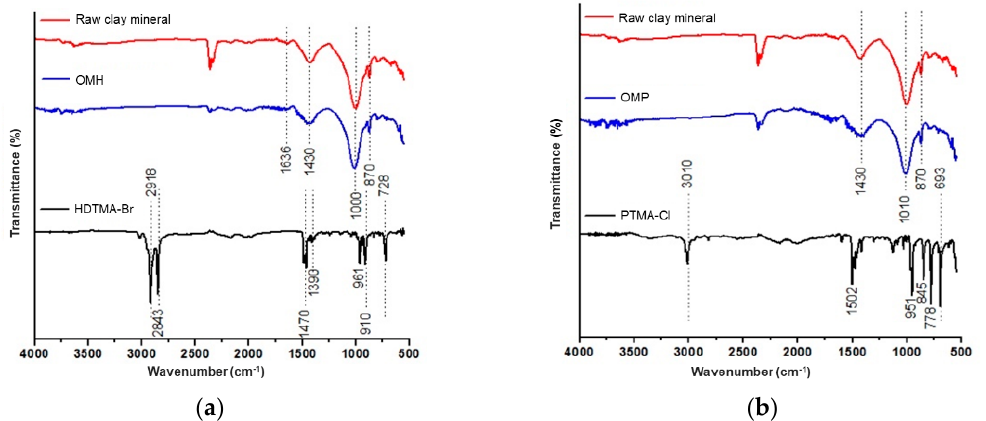
Figure 6. Fourier-transform infrared (FTIR) spectra of ( a ) raw clay mineral, OMH, and HDTMA-Br cationic surfactant; ( b ) raw clay mineral, OMP, and PTMA-Cl cationic surfactant.